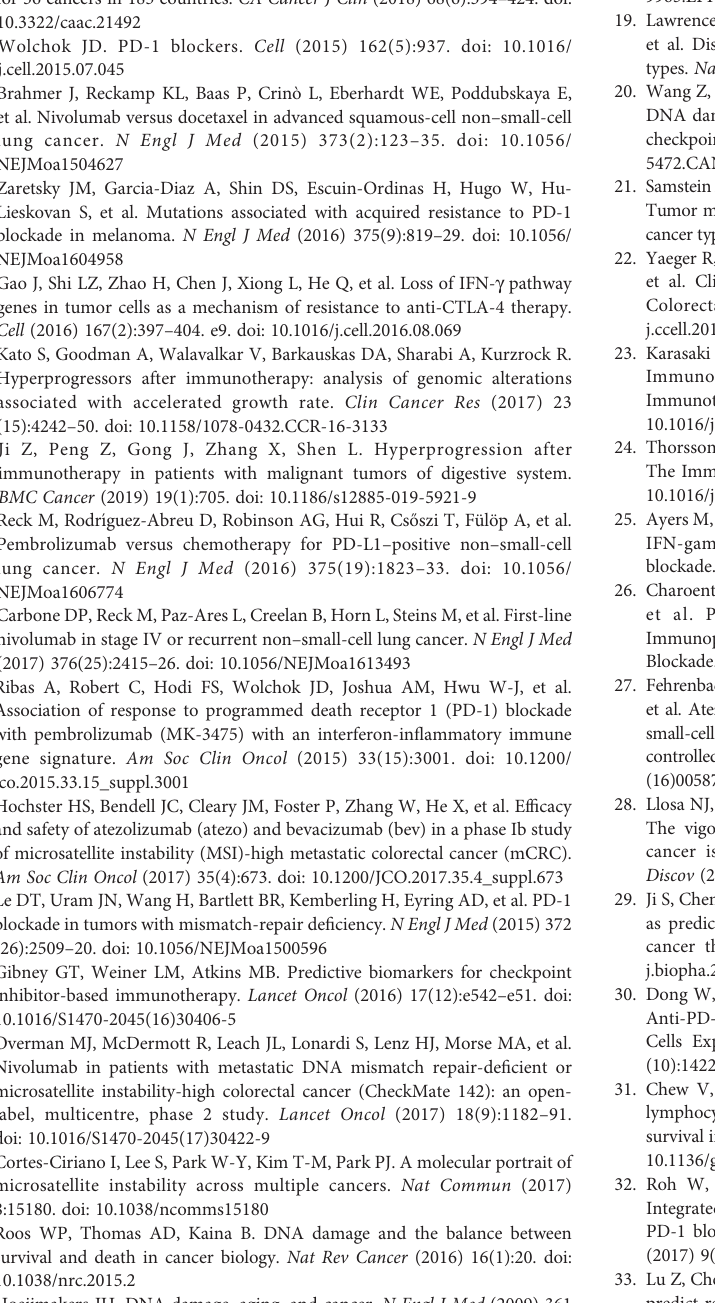
L1-positivity and the incidence of DDR mutation in a Chinese CRC cohort. (A) Distribution of TMB in the DDR Mut and WT groups. (B) The proportion of TMB- High and TMB-Low in the DDR Mut and WT groups. (C) The proportion of MSI-H and MSS in the DDR Mut and WT groups. (D) The proportion of PD-L1+ and PD- L1- in the DDR Mut and WT